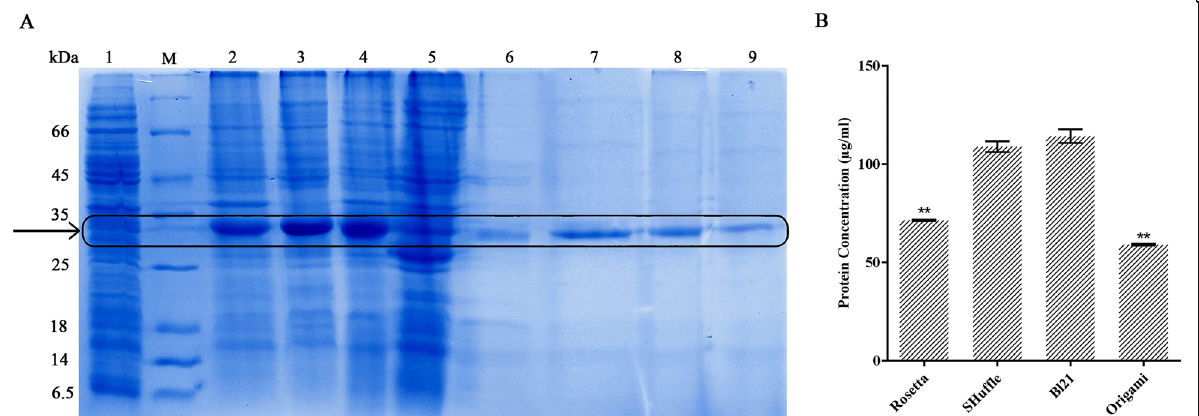
Fig. 4 Comparison between the amounts of purified soluble fraction of protein in four E. coli hosts. a SDS-PAGE analysis of the purified protin, lane 1: negative control harboring empty pET22b, M: molecular weight marker (6.5 to 116 kDa), lanes 2 to 5: induced bacterial lysate in 2: Rosetta TM 3: SHuffle TM T7, 4: BL21 TM (DE3), and 5: Origami TM (DE3); lanes 6 to 9: the purified recombinant anti-EpEX-scFv protein from soluble fractions 6: Rosetta TM 7: SHuffle TM T7, 8: BL21 TM (DE3), and 9: Origami TM (DE3). b Quantitatively protein concentration assessment for soluble fractions after purification. The amount of soluble anti-EpEX-scFv produced by E. coli Rosetta TM (DE3) strain and E. coli Origami TM T7 was significantly lower than that expressed by BL21 TM (DE3). There was no significant difference between the soluble amounts produced by BL21 TM (DE3) and SHuffle TM T7. Data were analyzed by unpaired, two-tailed Student ’ s t test and expressed as the mean ± SD of two experiments (** p <